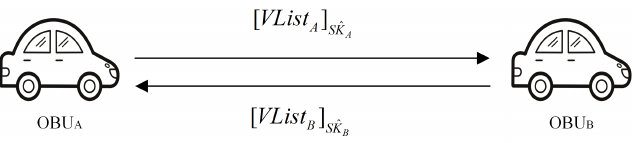
Figure 4. Virtual pseudonyms exchange